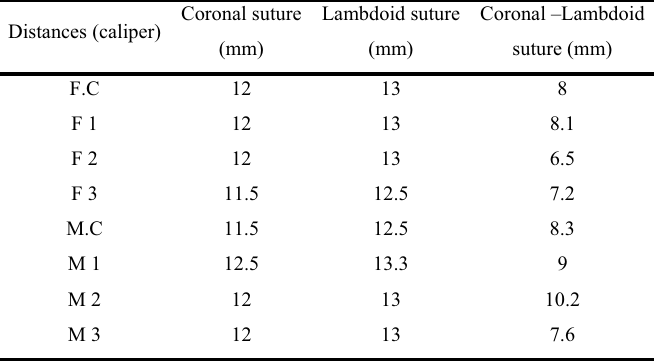
TABLE 1 - Each anatomic landmark measured with